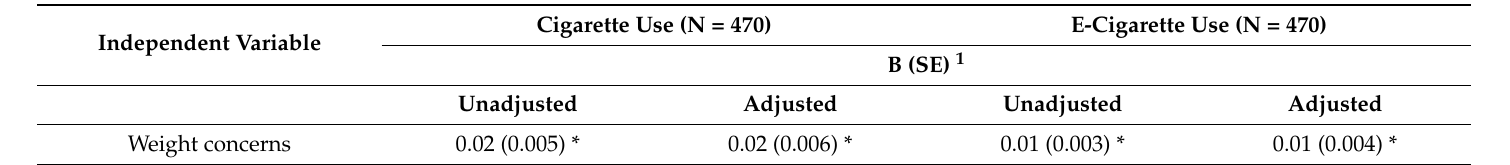
Table 4. Associations of weight concerns with current cigarette and e-cigarette use